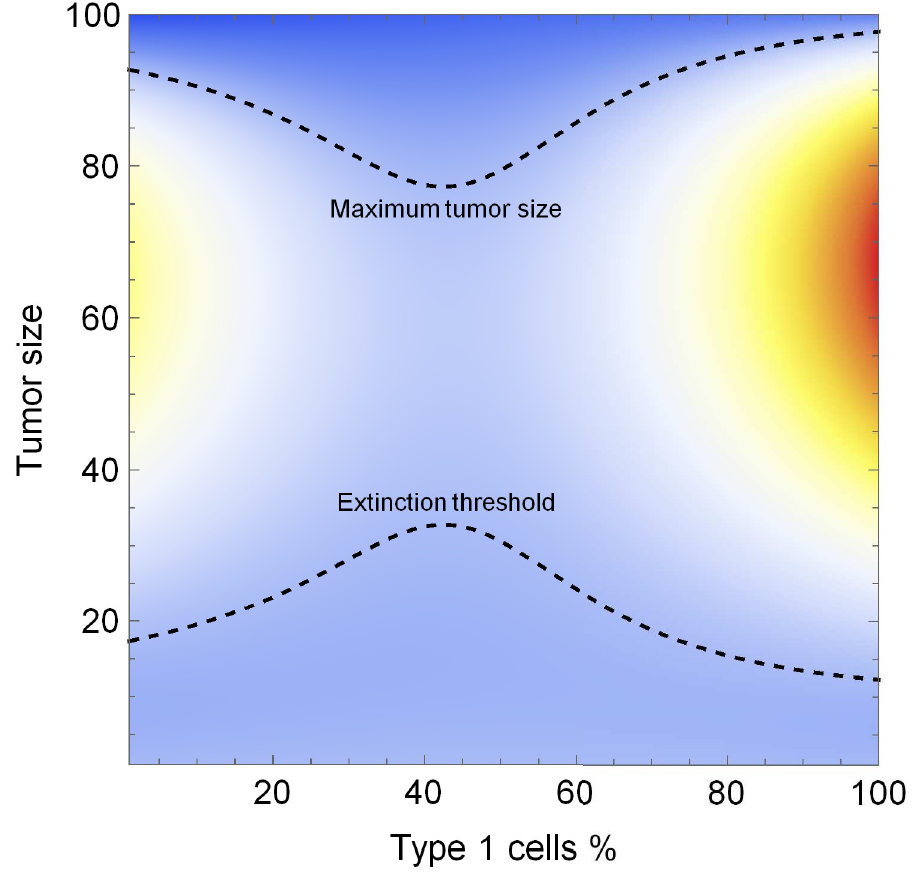
þ _ x for the possible size-composition ( x , g ) pairs, 1 2